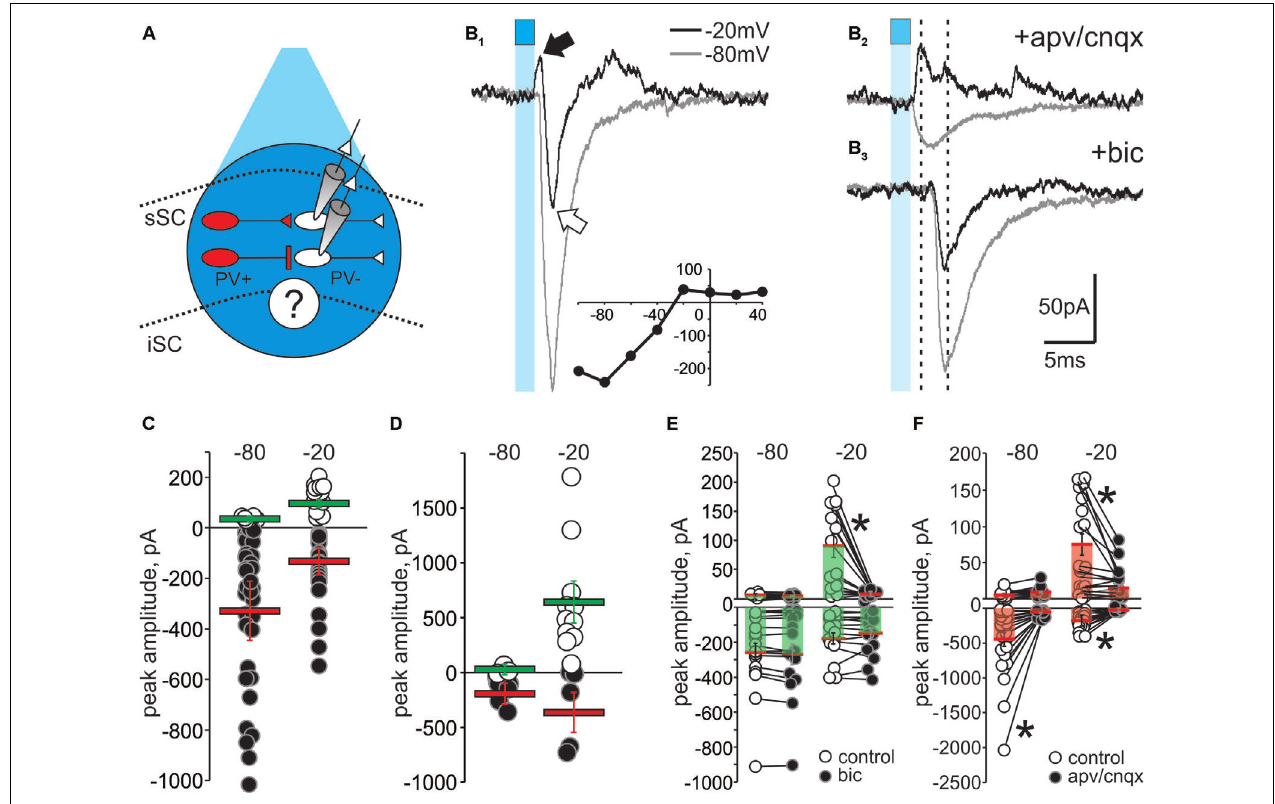
FIGURE 6 | Optogenetic activation of PV + neurons reveals functional GABAergic synapses in the SC. (A) Schematic diagram depicting the experimental design. Whole-cell recordings from PV − neurons (white) were obtained from visually identified neurons using IR-DIC in slices from Ai32;PV-Cre mice. To stimulate PV + neurons (red), pulses of blue light from a LED source were triggered through the objective (cyan circle, ∼ 5–10 mW). (B 1 ) 2 ms pulses of LED stimulation (cyan square) elicited inward currents when the holding voltage ( V h ) of PV − neurons was set at –80 mV (gray traces). With V h set at –20 mV (black traces), light stimulation evoked a biphasic response, with an outward current (black arrow) preceding an inward current (white arrow). Inset, I/V curve. (B 2 ) Bath application of APV/CNQX (50 µ M/10 µ M) diminished the light-evoked EPSC at V h –80 mV and –20 mV and isolated the light-evoked outward current at –20 mV (black). (B 3 ) After washout, bath application of bicuculline (10 µ M) eliminated the IPSC at V h –20 mV (black), thus isolating the EPSCs. (C,D) Peak amplitude plotted for all recorded IPSCs (white circles) and EPSCs (black circles) evoked in PV − neurons by optogenetic activation of PV+ neurons in sSC (C) and in Cx (D) . Red bars: EPSC mean ± SE; green bars: IPSC mean ± SE. (E) Peak amplitudes of light-evoked current measured in PV − neurons of sSC before ( o ) and after ( • ) bath application of bicuculline, which exclusively inhibited the light-induced outward currents recorded in PV − neurons at –20 mV. ∗ p < 0.05, paired t -test. (F) Peak amplitude currents before ( o ) and after ( • ) bath application of